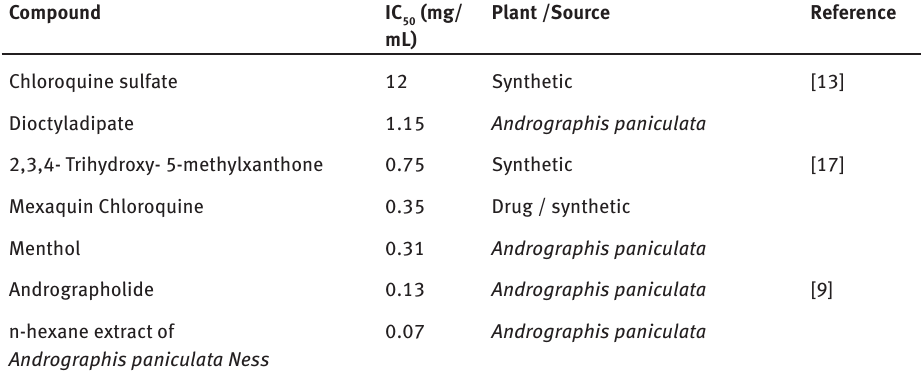
values of menthol and dioctyladipate with previous antimalarials. 50